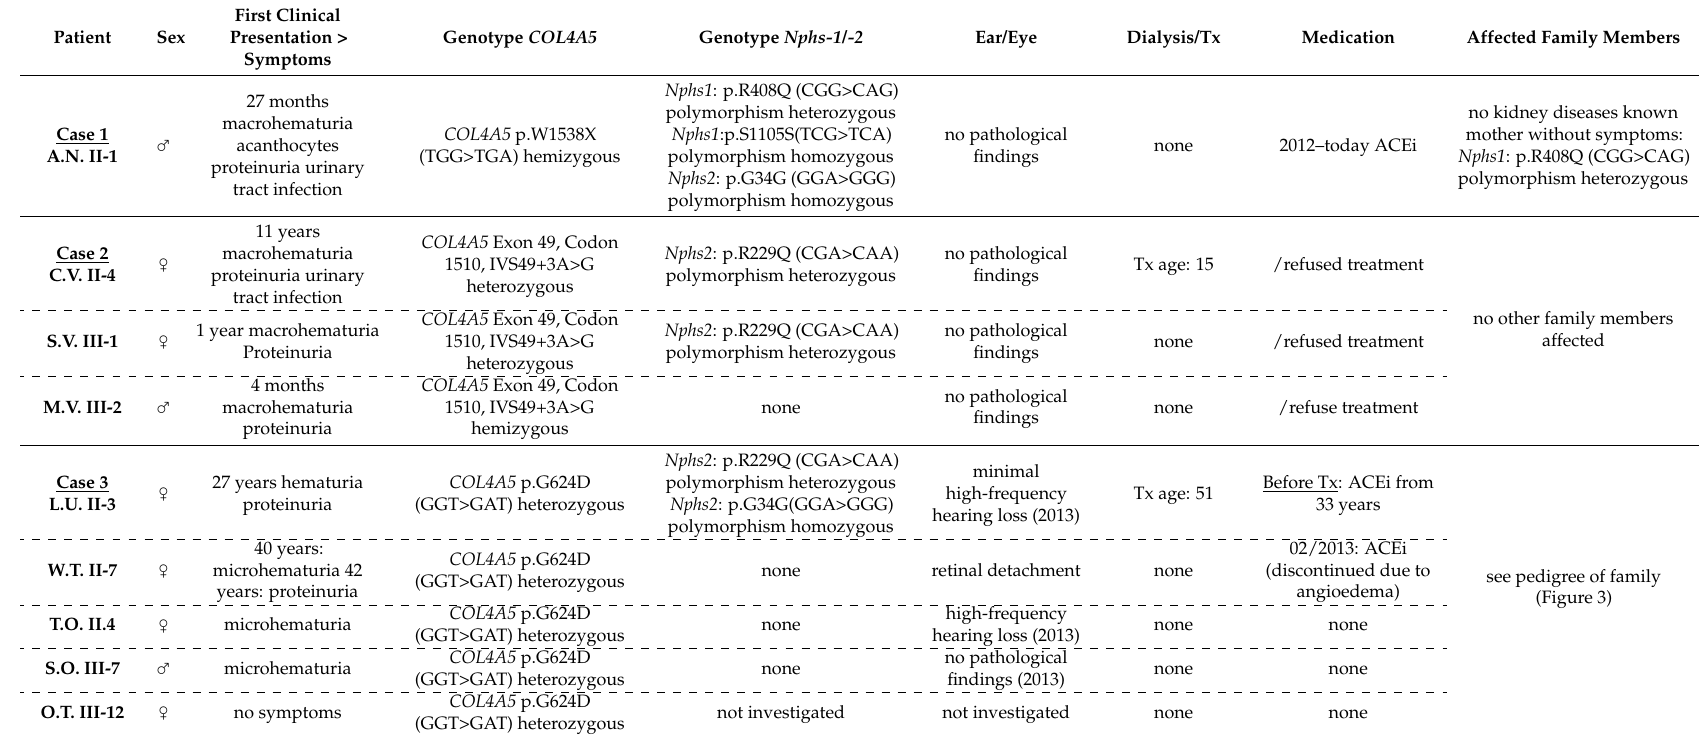
Table 1. Summary of patient phenotypes and